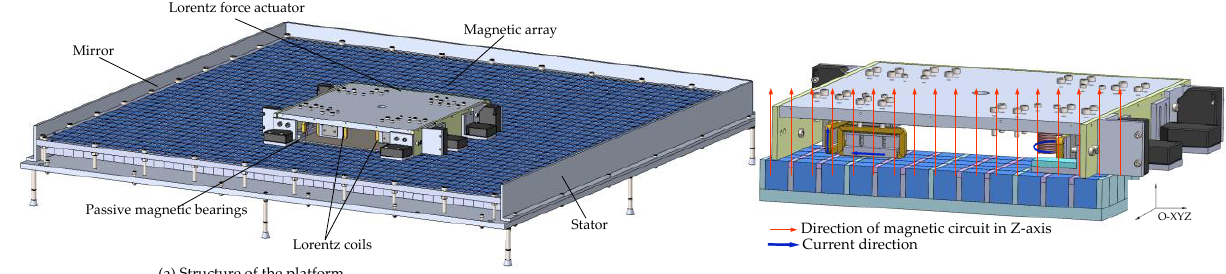
Figure 1. The structure of the 6-DOF magnetic suspension platform.